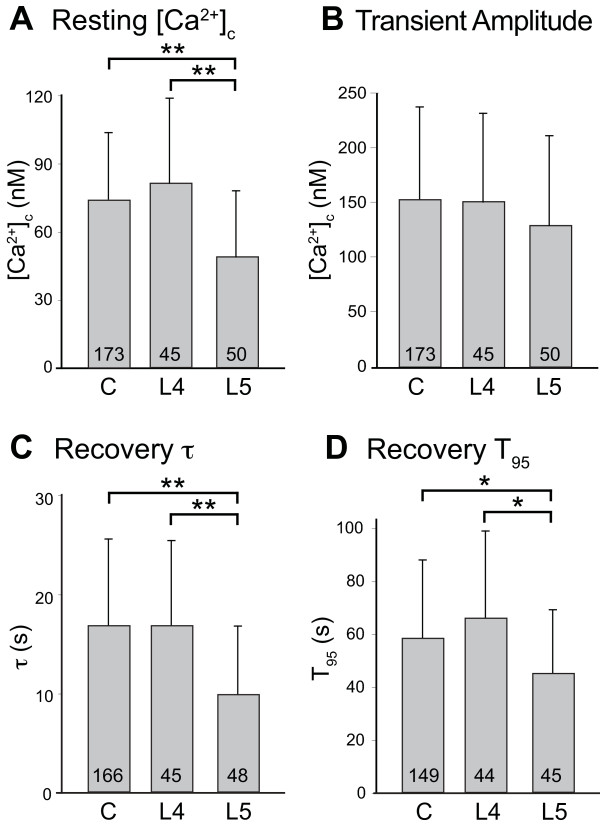
Effects of neuronal injury on resting [Ca2+]c and activity-induced transients. Neurons harvested from the 4th lumbar (L4) and L5 dorsal root ganglia after spinal nerve ligation were compared to control neurons (C). Injury in the L5 group decreased resting [Ca2+]c (A) but not transient amplitude (B). Recovery of transients induced by application of high K+ solution (50 mM for 0.3 s) was accelerated in the L5 population after injury, measured by both the recovery rate constant (τ) and by the time to achieve 95% recovery to baseline (T95). Mean ± SD; numbers in bars indicate n; * P < 0.05, ** P < 0.01 by ANOVA with Bonferroni’s post hoc test.